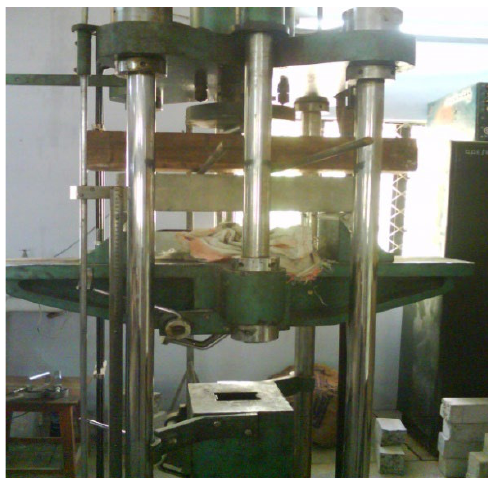
Figure 2. Flexural strength testing setup.